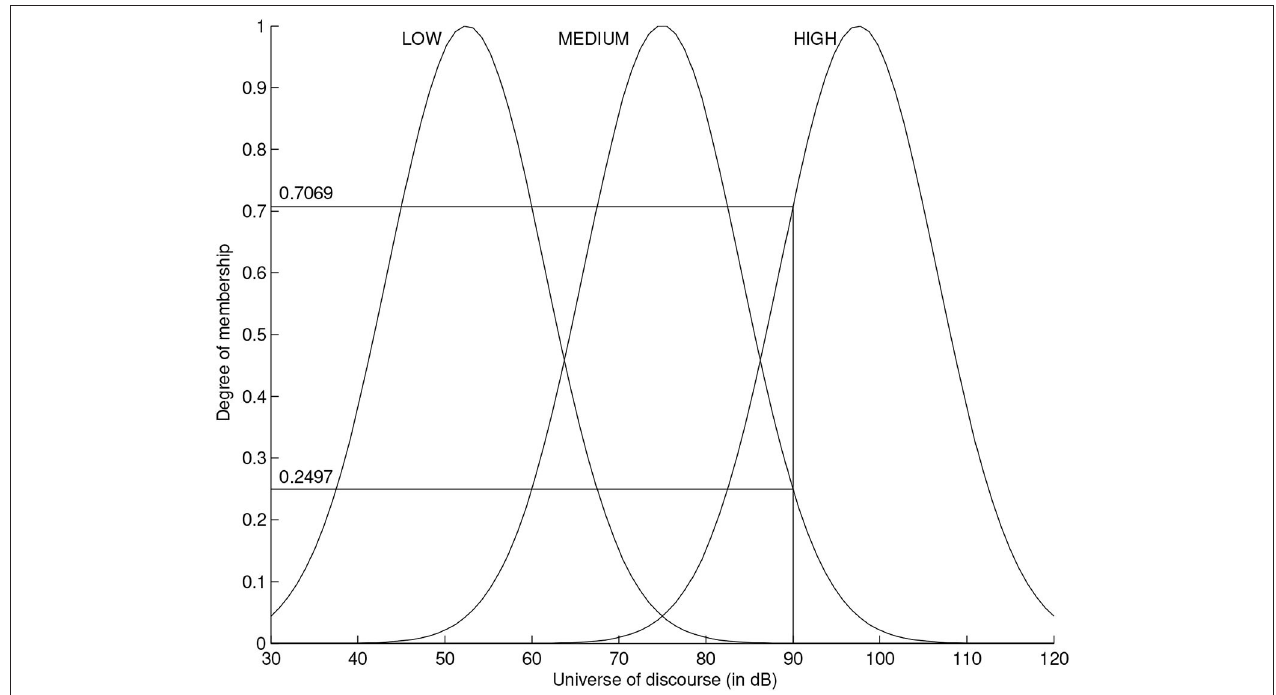
FIGURE 1 | Fuzzification of the concept “intensity.” The intensity level in dB is fuzzified into three fuzzy sets, labeled LOW, MEDIUM, and HIGH. The crisp value of 90 dB belongs to both the HIGH and MEDIUM sets in different